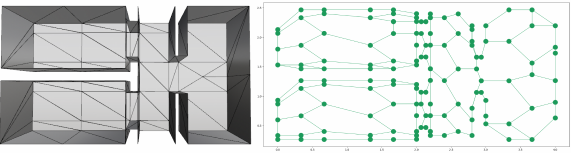
Figure 4. Mesh M of the test dataset and its dual graph G